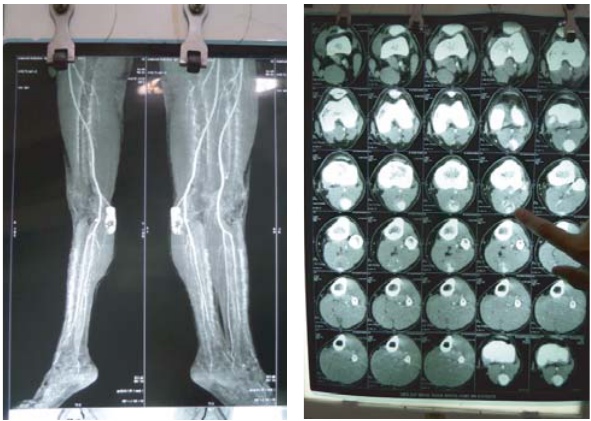
Fig 1. Angiogram showing dye filled sac along with soft tissue